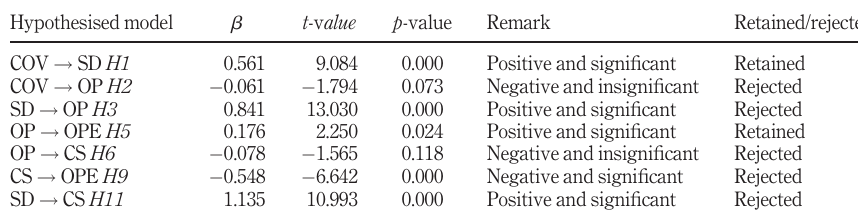
Table 4. Path model and direct